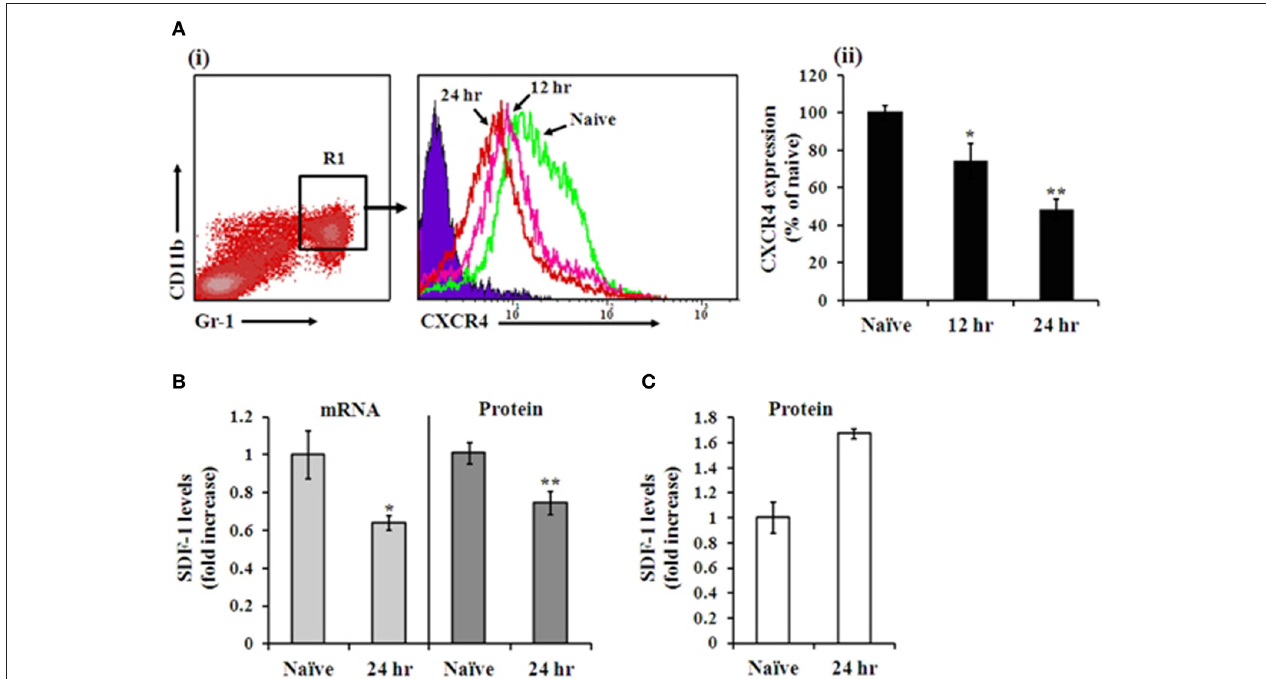
FIGURE 3 | Analysis of CXCR4 and SDF-1 levels in the BM during pneumonic plague. A(i) Representative FACS histogram analysis showing CXCR4 expression on Gr-1 high /CD11b + neutrophils at 12h (pink line) and 24h (red line) post infection, compared to naïve mice (green line) (blue area indicates isotype control staining). A(ii) Summary of CXCR4 expression on